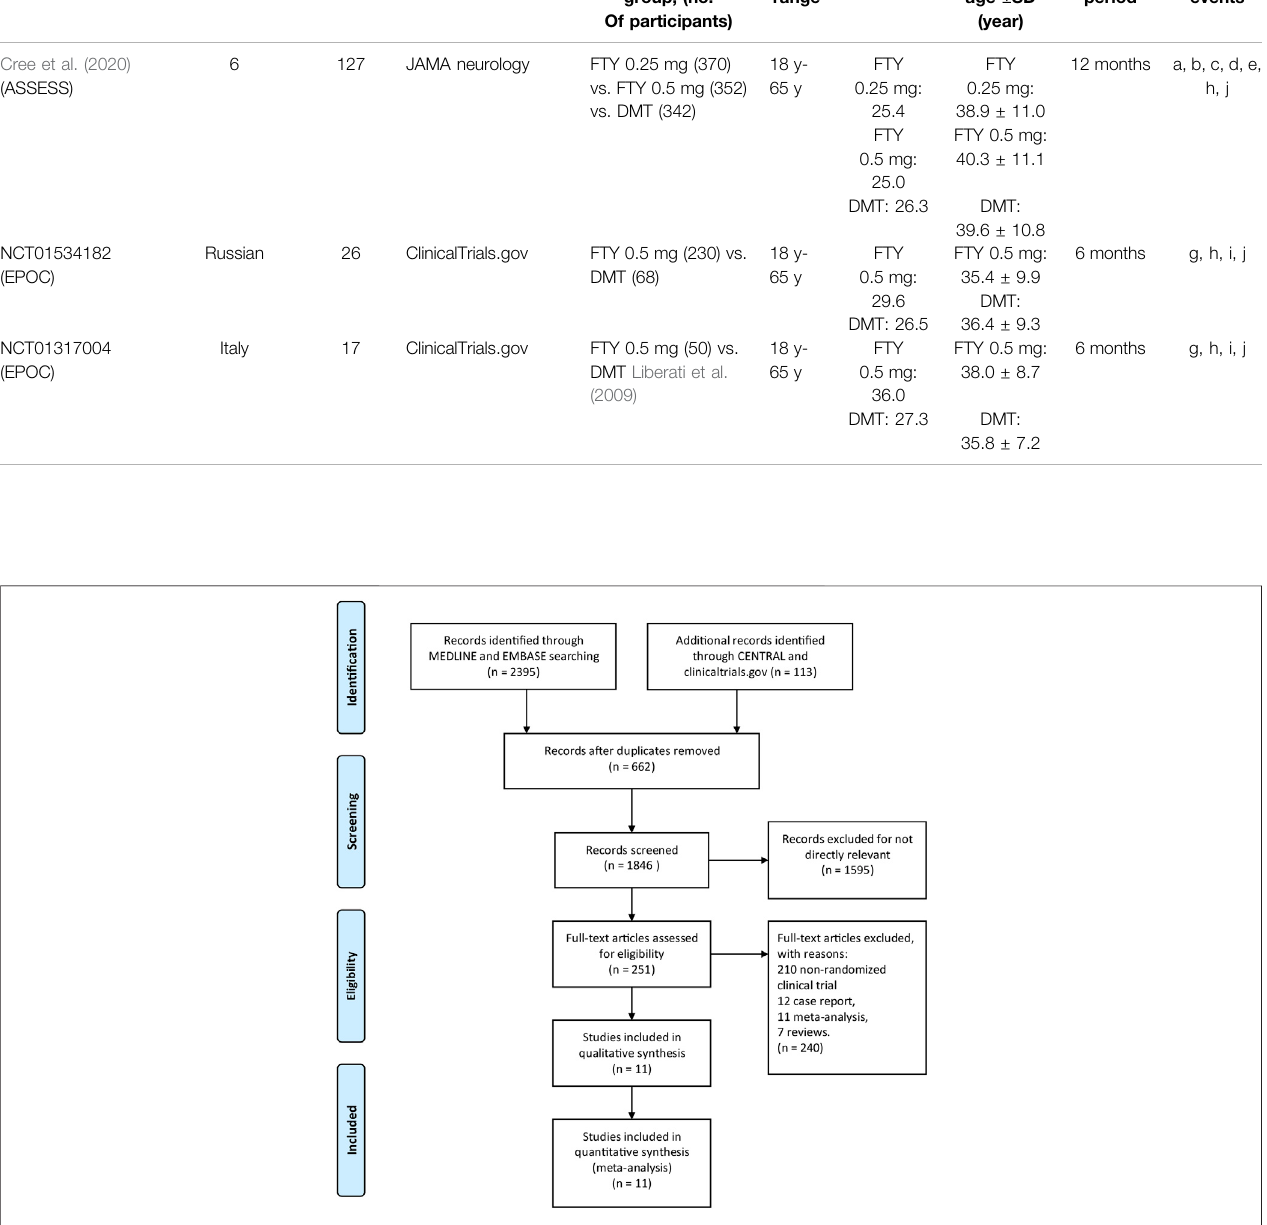
FIGURE 1 | The study search, selection, and inclusion process.